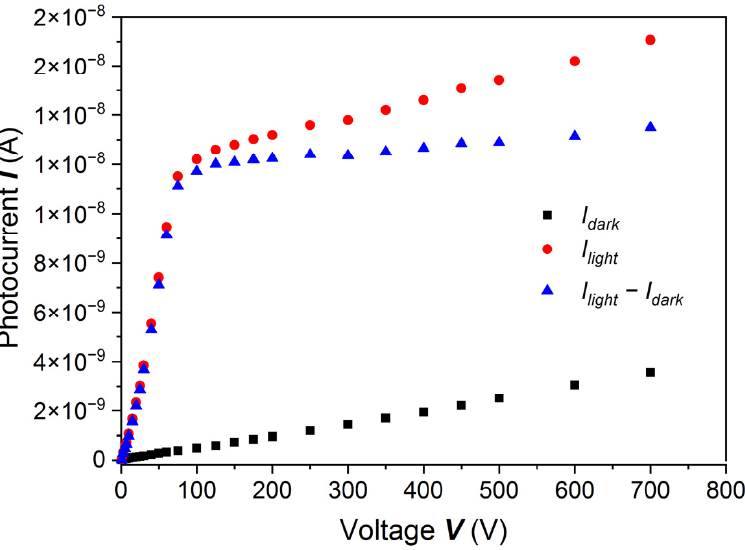
Figure 6. PC-V characteristics for a (Cd,Mn)Te:In sample etched with 20% HCl. At voltages up to ~75 V the curve does not look like the exponential Hecht–Many function, rather like a straight line or power-like function. The illumination photons energy was very close to E g , i.e., ħω = 1.590 eV = E g + 15 meV.